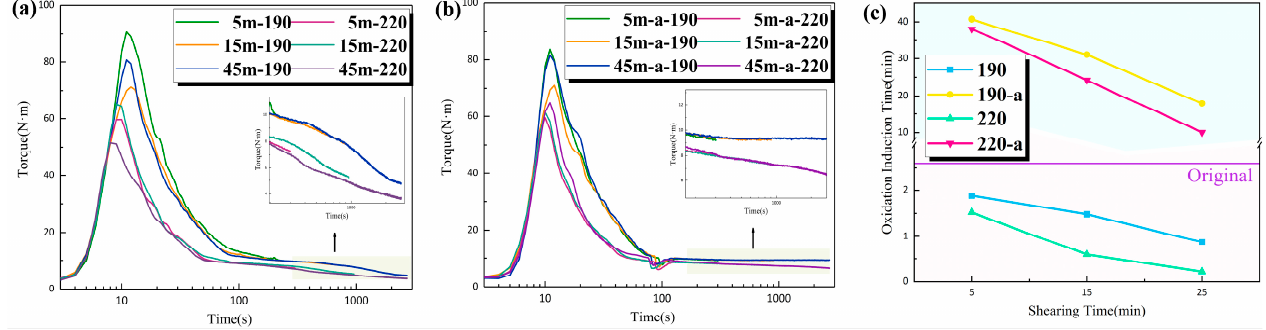
Figure 1. The rheogram of samples. ( a ): Torque-time curves of samples without antioxidant; ( b ): Torque-time curves of samples with antioxidant; ( c ): The equilibrium torque with shear time and temperature for each sample.